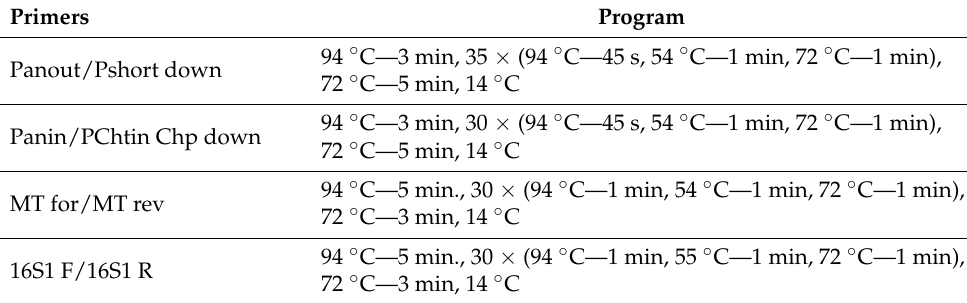
Table 2. PCR programs applied in this